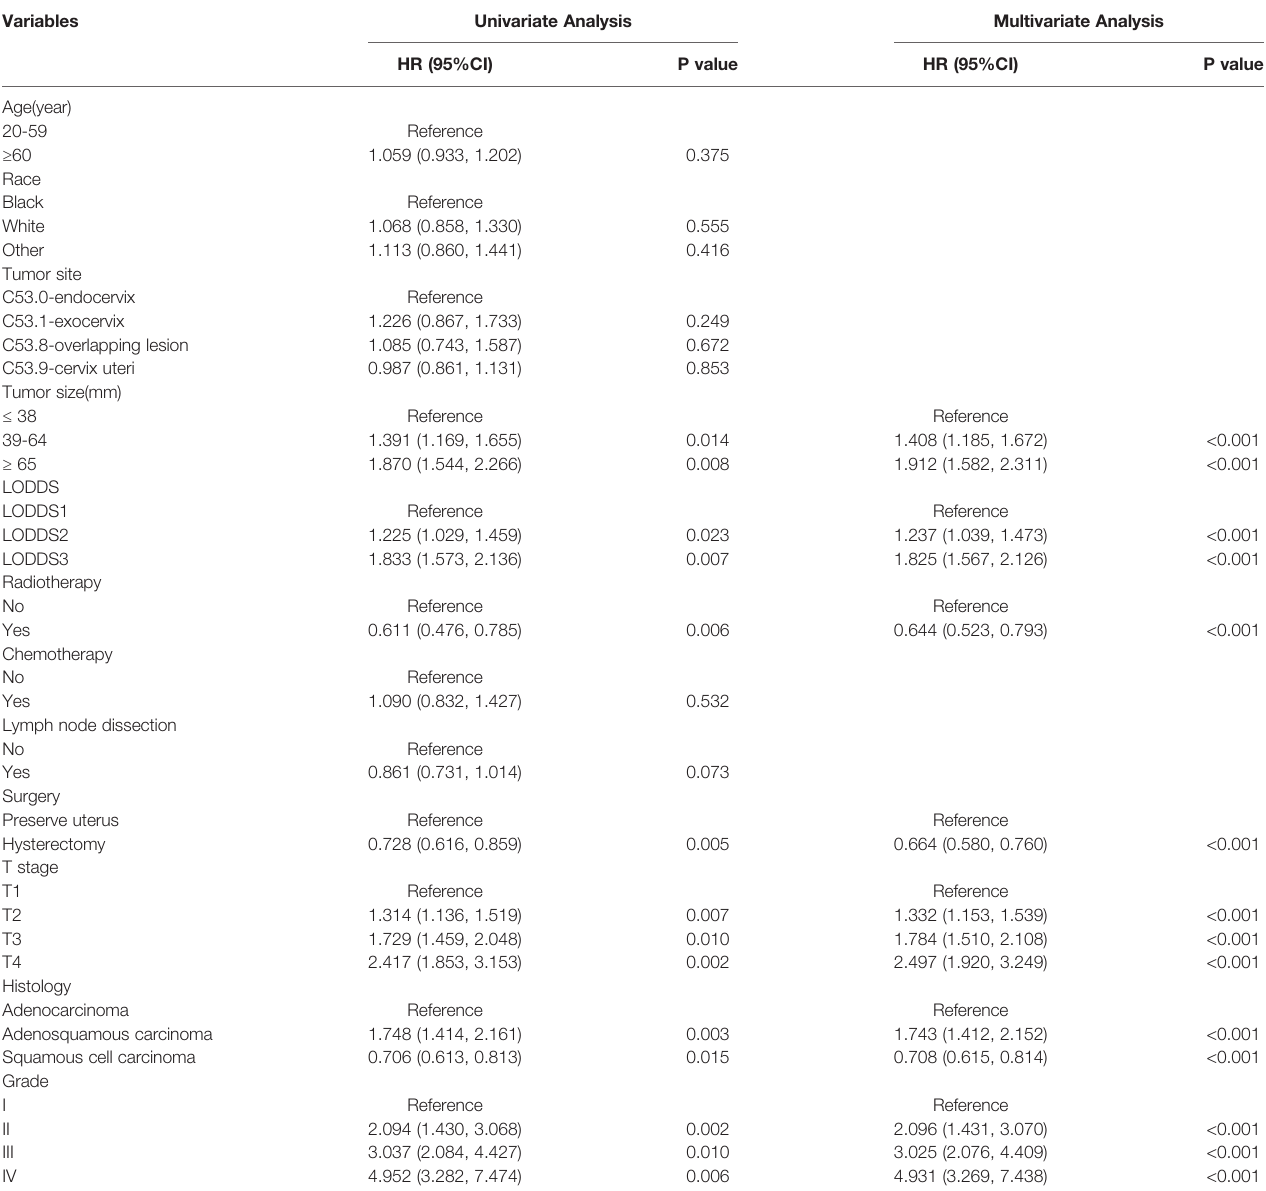
TABLE 2 | Univariate and multivariate Cox regression analysis of OS in cervical cancer patients with lymph node metastasis (training